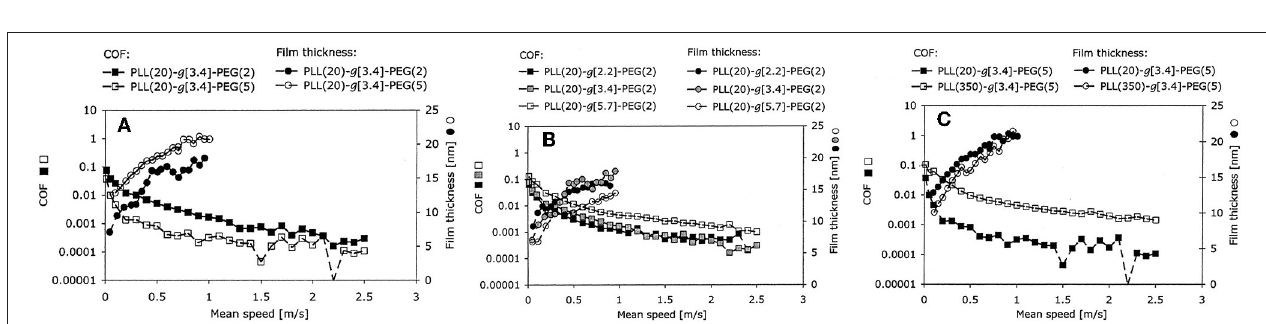
FIGURE 2 | Effects of (A) the molecular weight of the PEG side chains, (B) the Lys/PEG grafting ratio, and (C) the molecular weight of the PLL backbone on the COF. The lubricant film thickness was measured with respect to the speed using an MTM and ultrathin-film interferometry. Muller et al. (2003) Copyright 2003, Springer.